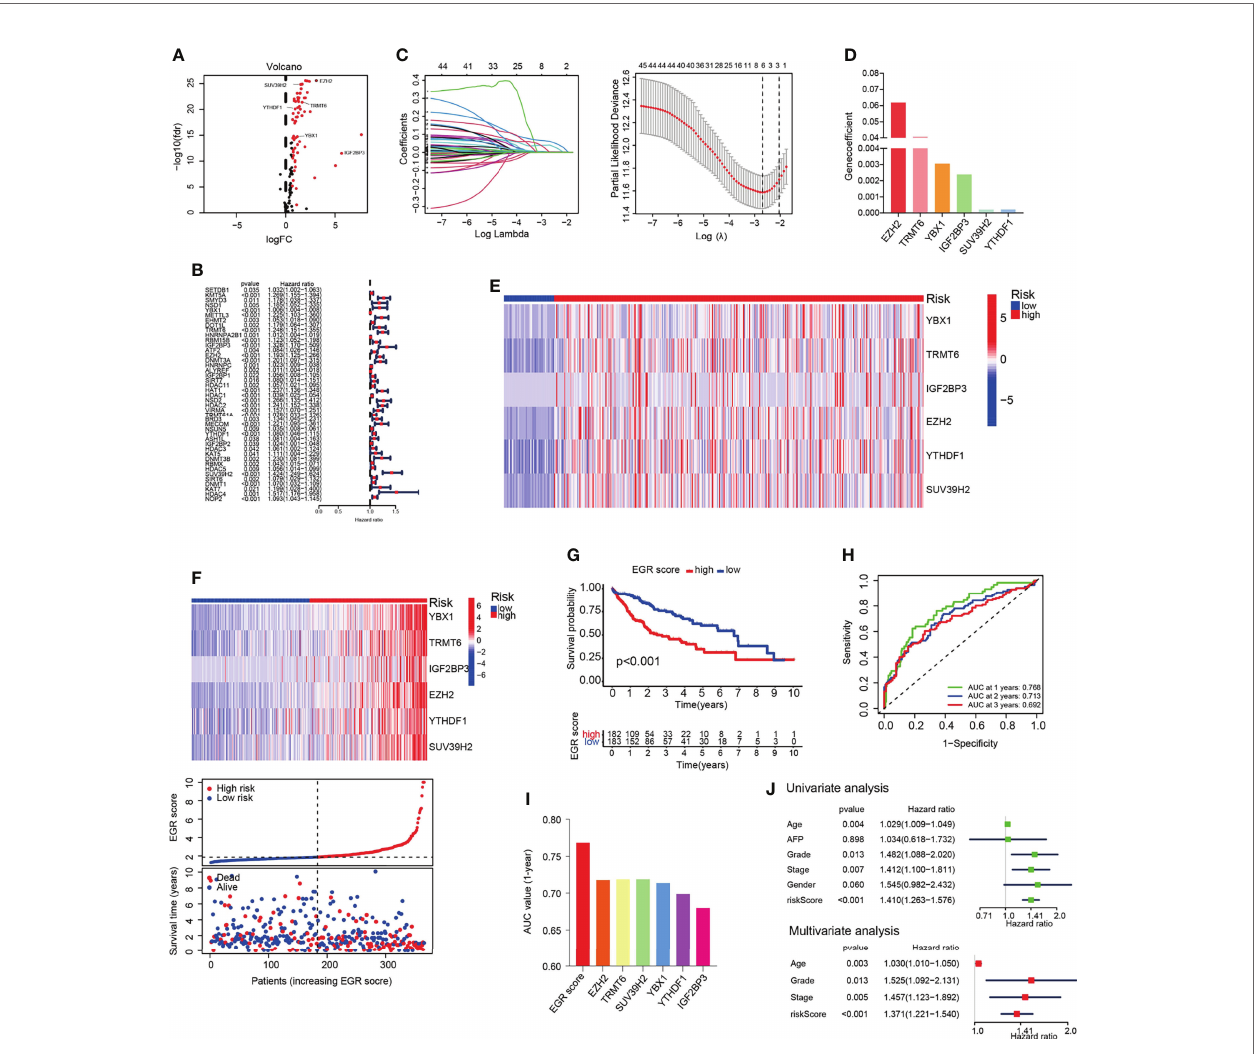
FIGURE 1 | Construction of EGR signature in the TCGA-LIHC cohort. (A) Volcano plot of the epigenetic regulators. (B) Univariate Cox analysis of the genes selected by DEGs. (C) Cross-validation for tuning the parameter selection in the LASSO regression. (D) The coef fi cients of the 6 OS-related genes. (E) Heatmap of genes consisted in EGR signature in normal and HCC patients. (F) Heatmap of genes consisted in EGR signature, the distribution of patients, and the survival status for each individual in low- risk and high-risk HCC patients. (G) Kaplan – Meier curves for the OS of patients between the high- and low-risk groups. (H) Time-dependent ROC curves demonstrated the predictive ef fi ciency. (I) Area under the ROC curve of 1-year survival. (J) Univariate and multivariate Cox regression analyses for the